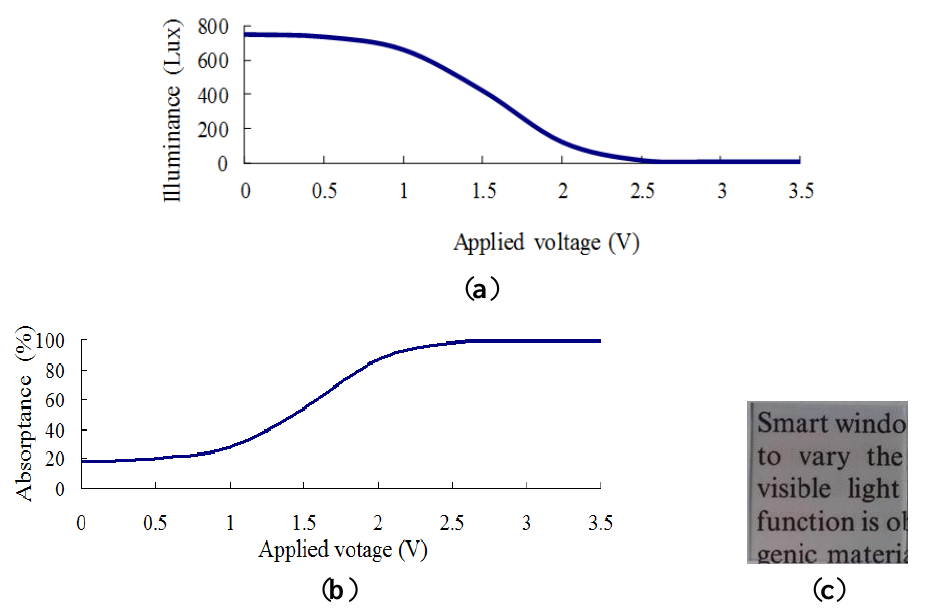
Figure 10. Transmittance and absorptance properties of ITO/WO electrolyte/ITO stack given electrolyte thickness of 1,000 nm and incident illuminance of 900 Lux. ( a ) Transmittance given applied voltage of 0–3.5 V; ( b ) absorptance given applied voltage of 0–3.5 V; and ( c ) transparency of EC stack given no applied